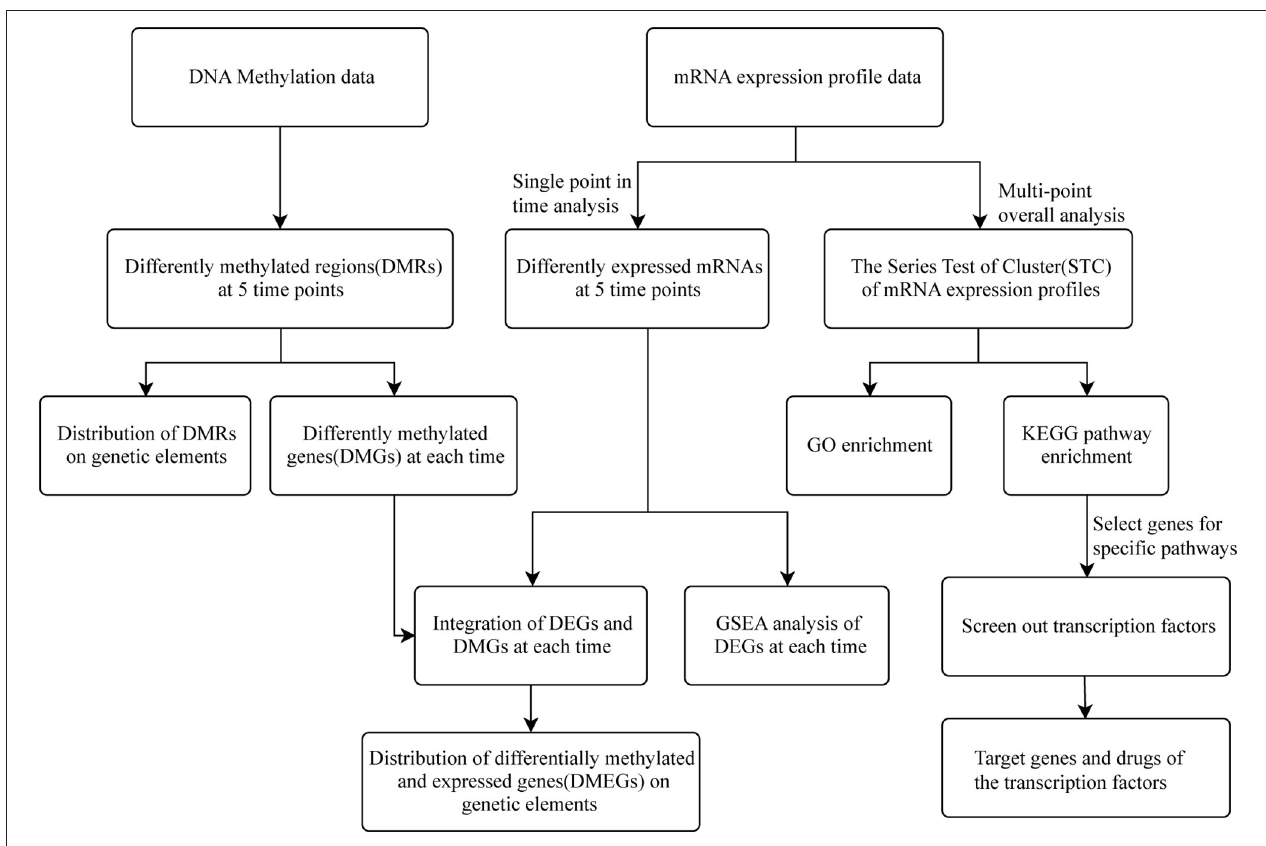
FIGURE 1 | Flow chart of this